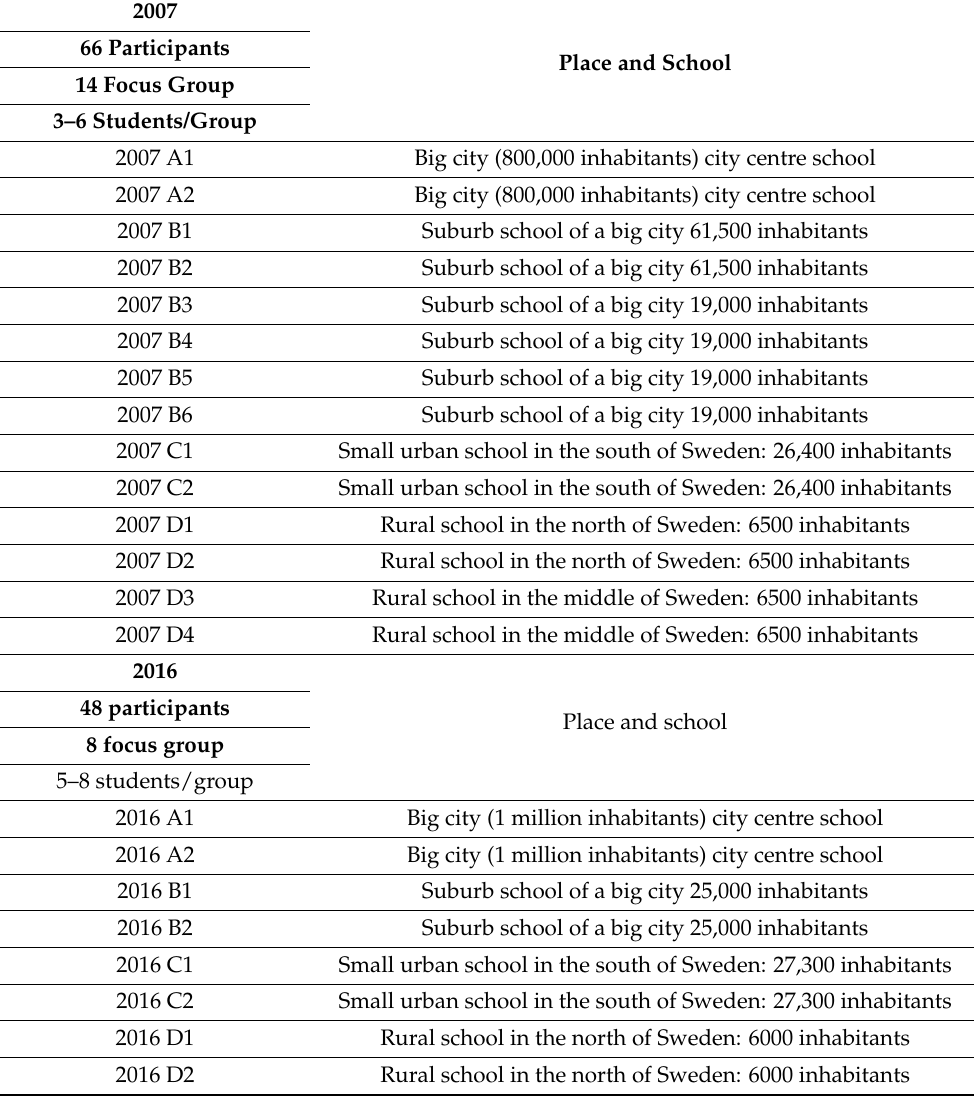
Table 1. Overview of schools coded with the year of the study (2007 and 2016) and the letters A–D to provide information about which focus group interview the quotes come